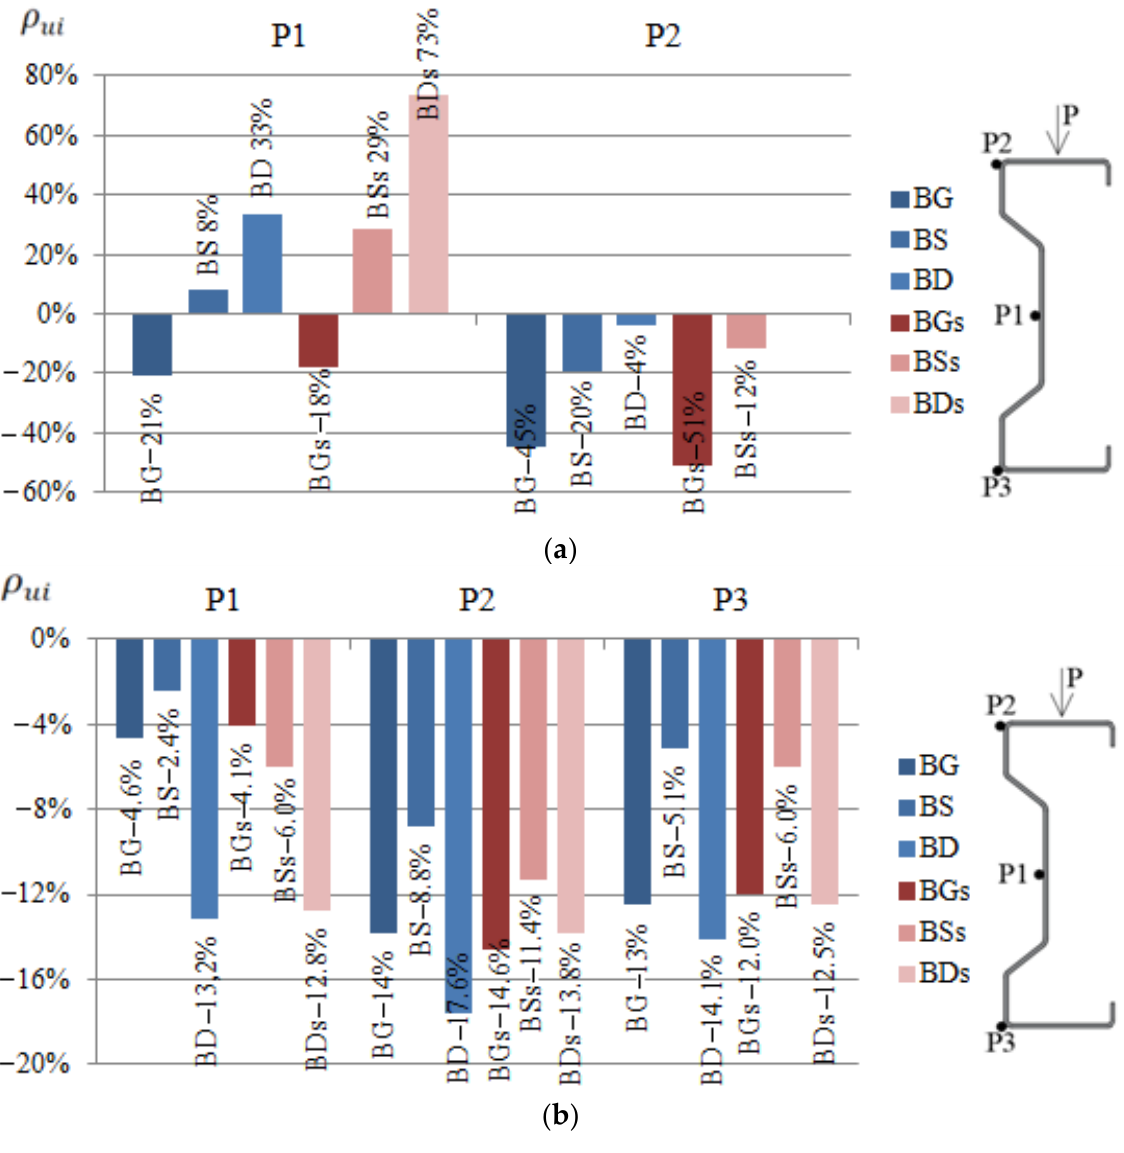
Figure 7. Percentage reduction of displacements ρ ui at P1, P2 i P3 points of the tested beams reinforced with steel or CFRP tapes on: ( a ) the horizontal, in the direction perpendicular to the longitudinal axis of the beam, ( b ) the vertical, in relation to the reference beams at a load of 25 kN.